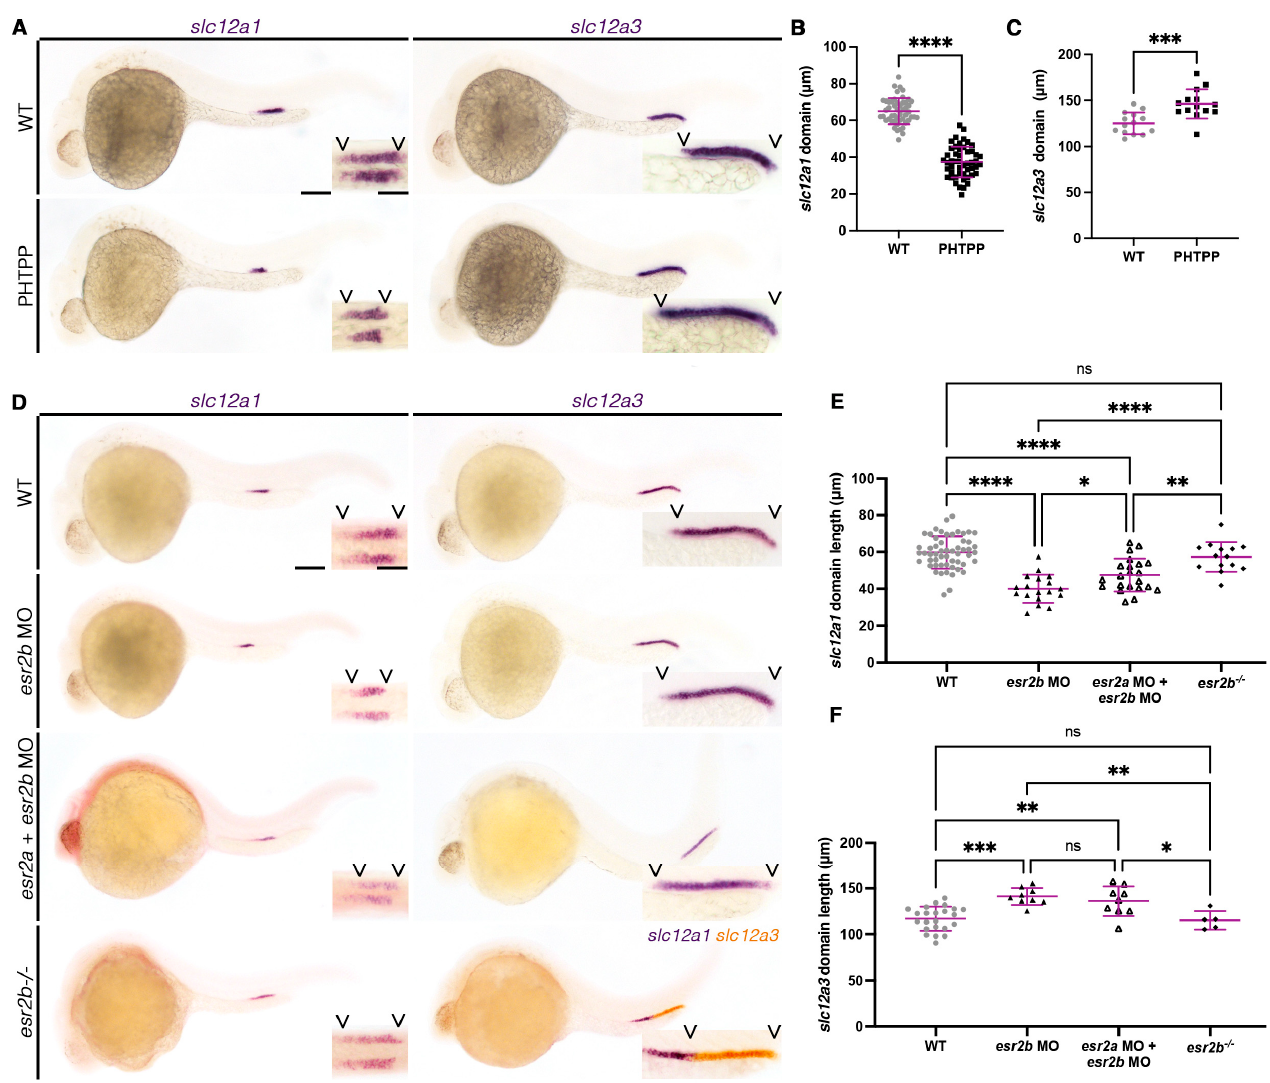
Figure 3. Chemical and genetic inhibition of Esr2b results in altered distal segmentation. ( A ) The 28 ss WT (top) and 18 µM PHTPP (bottom) treated animals stained via WISH for the DE marker ( slc12a1 ) (left) or the DL marker ( slc12a3 ) (right). Scale bar = 100 µm for lower magnification, scale bar = 50 µm for higher magnification. ( B , C ) DE and DL domain lengths at 28 ss in micrometers. ( D ) The 28 ss WT (top), esr2b MO-injected (second row), esr2a and esr2b double-MO-injected (third row), and esr2b mutant (bottom row) animals stained via WISH for the DE marker ( slc12a1 ) (left) or the DL marker ( slc12a3 ) (right). Scale bar = 100 µm for lower magnification, scale bar = 50 µm for higher magnification. ( E , F ) DE and DL domain lengths at 28 ss in micrometers. Data presented on graphs are represented as mean ± SD. * p < 0.05, ** p < 0.01, *** p < 0.001, and **** p < 0.0001 (t-test or ANOVA). To confirm the results of the SERM screen and further understand which receptor may be the primary player in the kidney, we used morpholinos targeting esr1 , esr2a, and esr2b to knockdown each receptor, respectively. Each of these tools was previously vali- dated to interfere with splicing for each specific target, while off-target alterations in splic- ing were not observed [53]. Knockdown of esr1 and esr2a did not result in changes to the DE (Figure S7). However, esr2b deficiency resulted in a decreased DE, and increased the length of the DL, which recapitulates the PHTPP phenotype, though this occurred at a decreased penetrance compared to PHTPP treatment (Figure 3D–F). We hypothesized that esr2b may be the major player in distal cell development. However, it is plausible that esr2a may serve a redundant role. To address this, we knocked down esr2a and esr2b in combination. The double-deficient animals did not exhibit more severe differences in DE